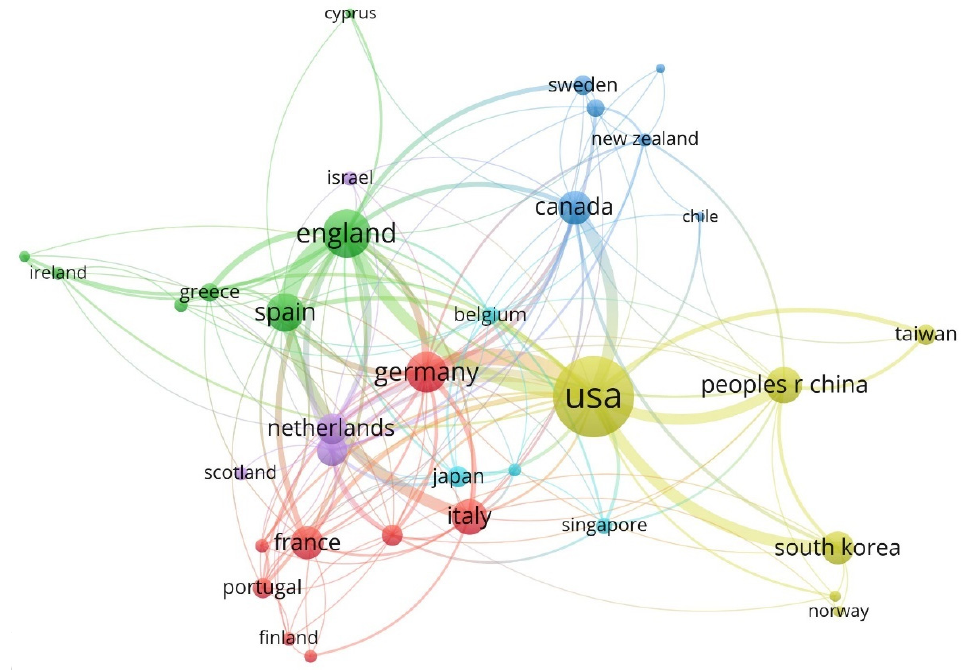
Figure 9. Map of country collaboration networks.